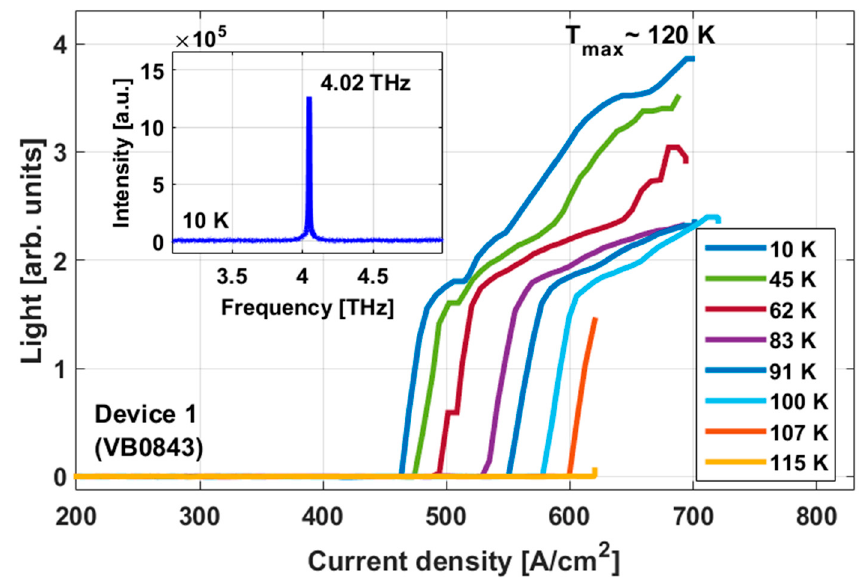
Figure 2. Pulsed light–current and spectrum (inset) measurements of Device 1 (wafer VB0843). The measurements were conducted in pulsed mode with square pulse form at the width of 500 ns and frequency of 500 Hz.